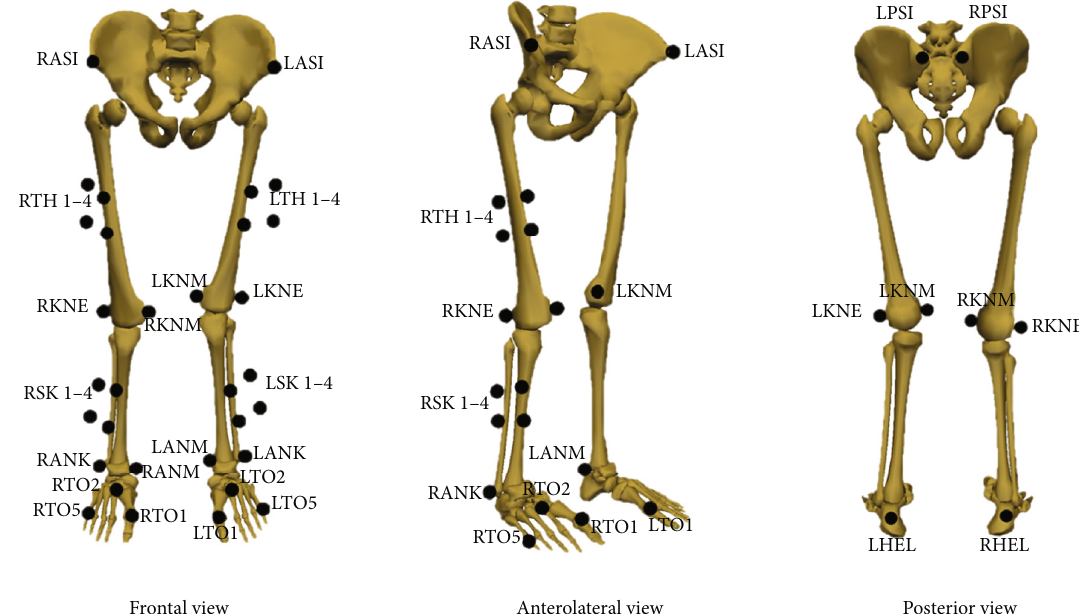
Figure 1: Illustration of the marker